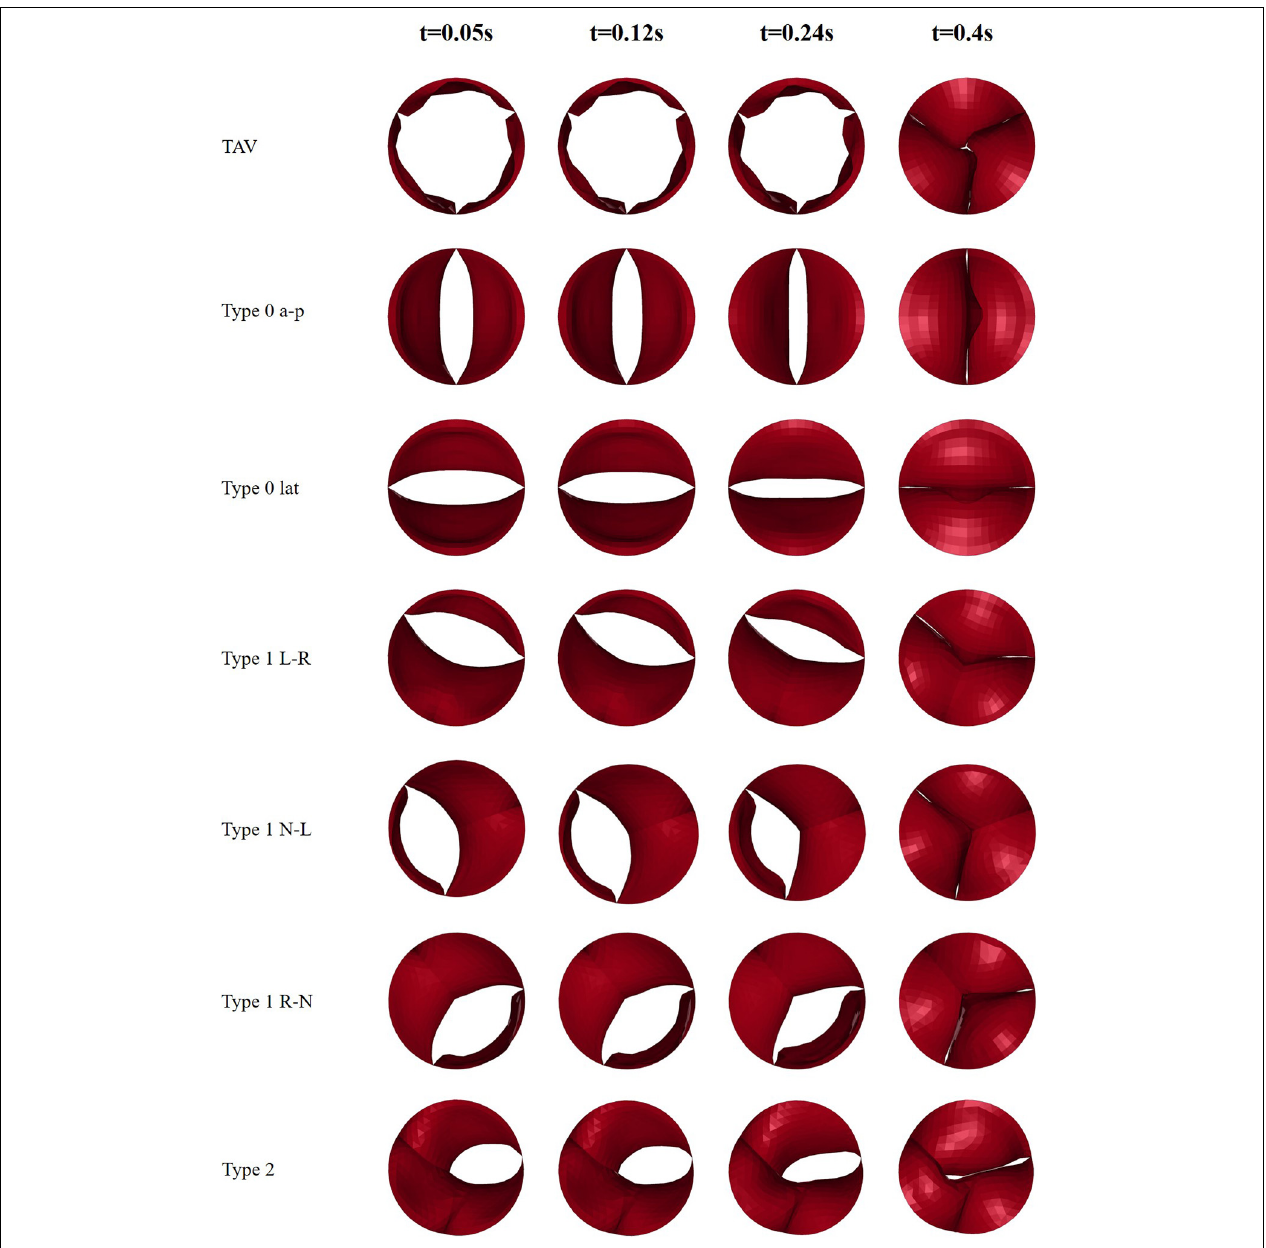
FIGURE 5 | Snapshots of leaflets motion of TAV and BAV models at four moments ( t = 0.05, 0.12, 0.24, 0.4